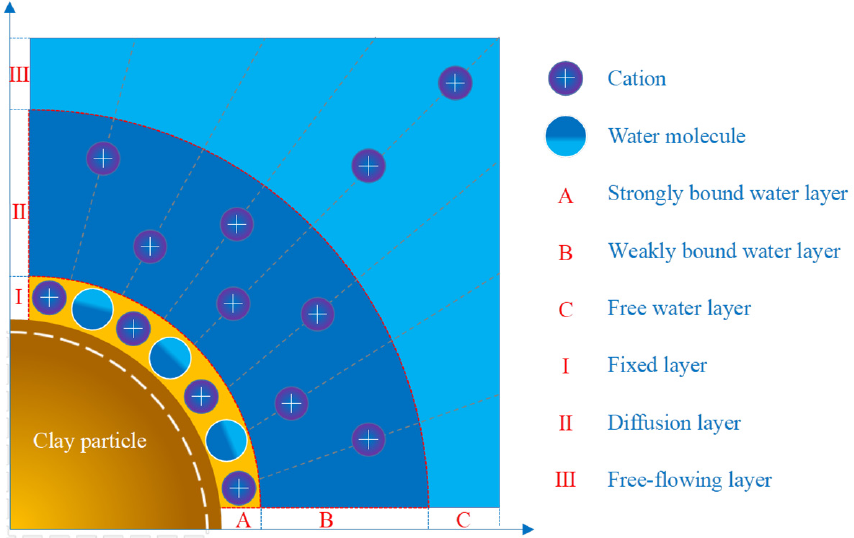
Figure 9. Bound water around a clay particle (reproduced with permission from from Kong et al., Soil Mechanics and Foundations; published by China Electric Power Press: Beijing, China, 2015 [36]).